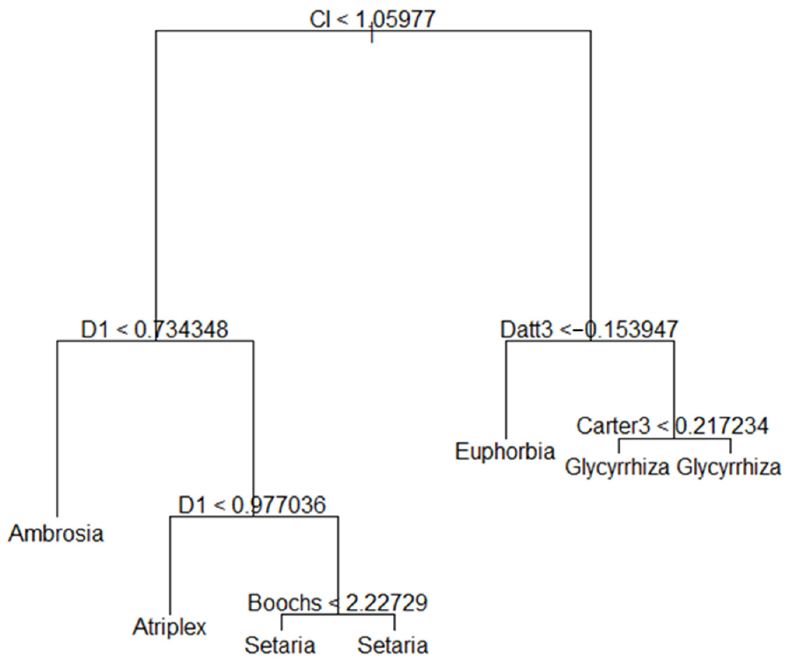
Figure 12. VI DT for Ambrosia artemisiifolia , Atriplex tatarica , Glycyrrhiza glabra , Euphorbia seguieriana , and Setaria pumila .